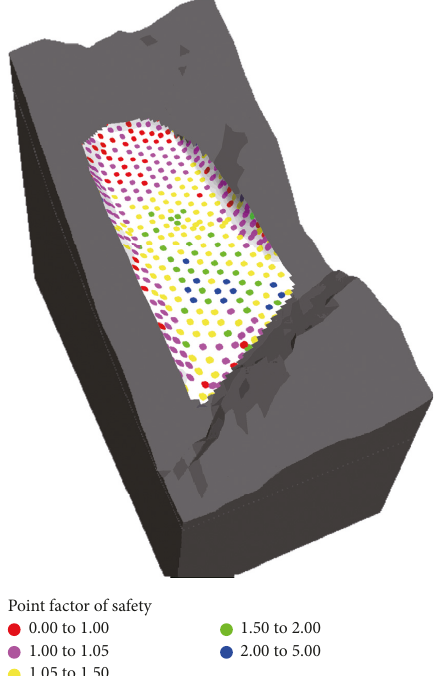
Figure 8: Point factor of safety at the natural state.